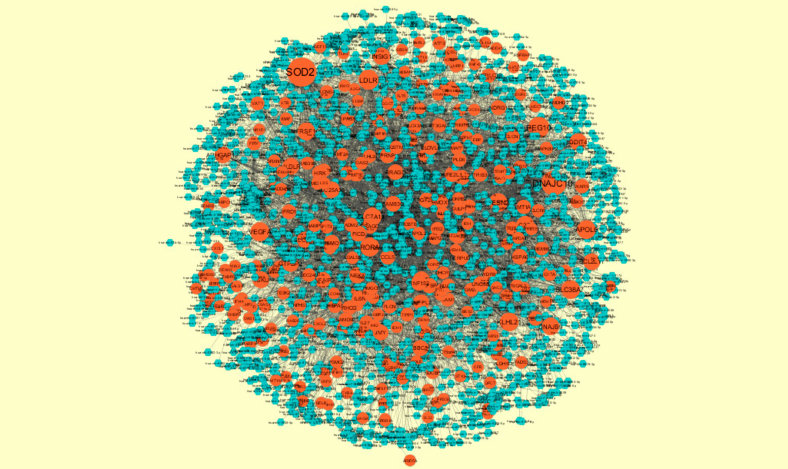
Figure 14. The network of down-regulated di ff erential expressed genes (DEGs) and their related miRNAs. The orange-red circle nodes are the down-regulated DEGs, and blue diamond nodes are the